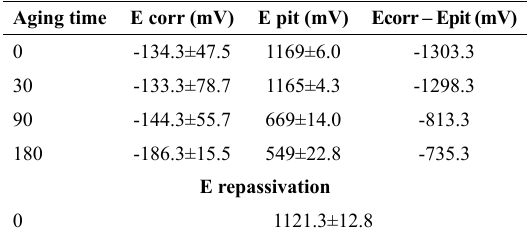
Table 4. Corrosion and pitting potentials and electrical work during polarisations for the different ageing condition